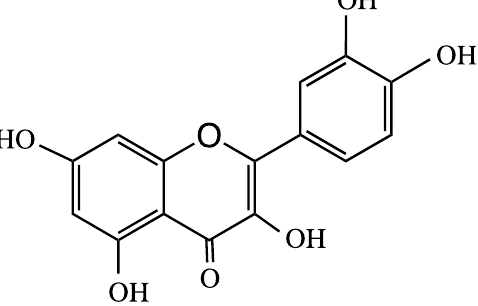
Figure 2. Molecular structure of quercetin.